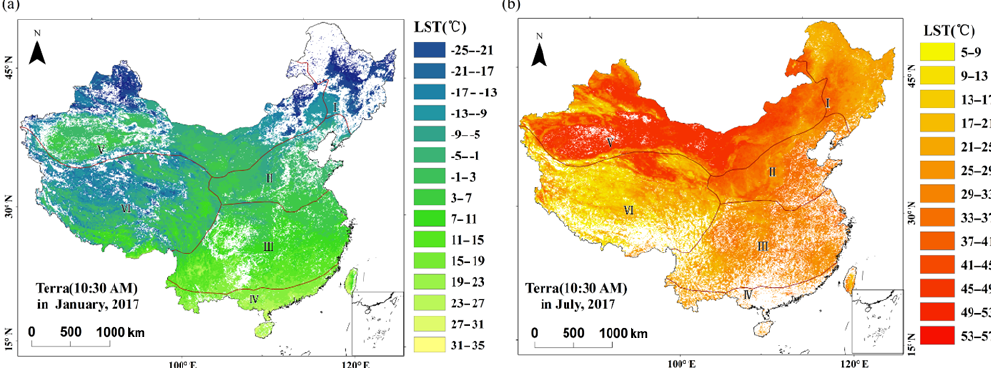
Figure 4. Spatial distribution of valid data after pixel filtering (see text for details) for monthly MODIS LST data from Terra during the daytime in (a) January and (b) July. Areas of invalid data are